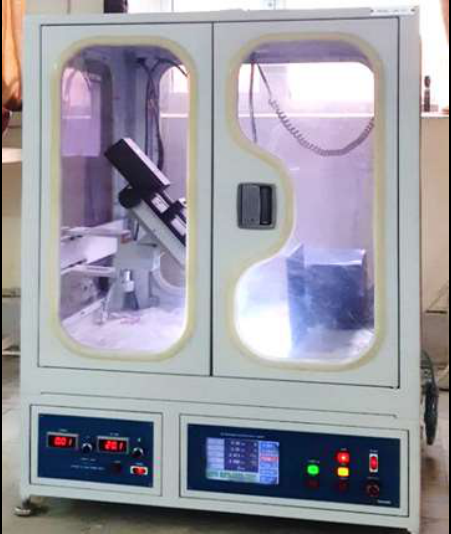
Figure 1: Photograph of electrospinning apparatus for nanofiber